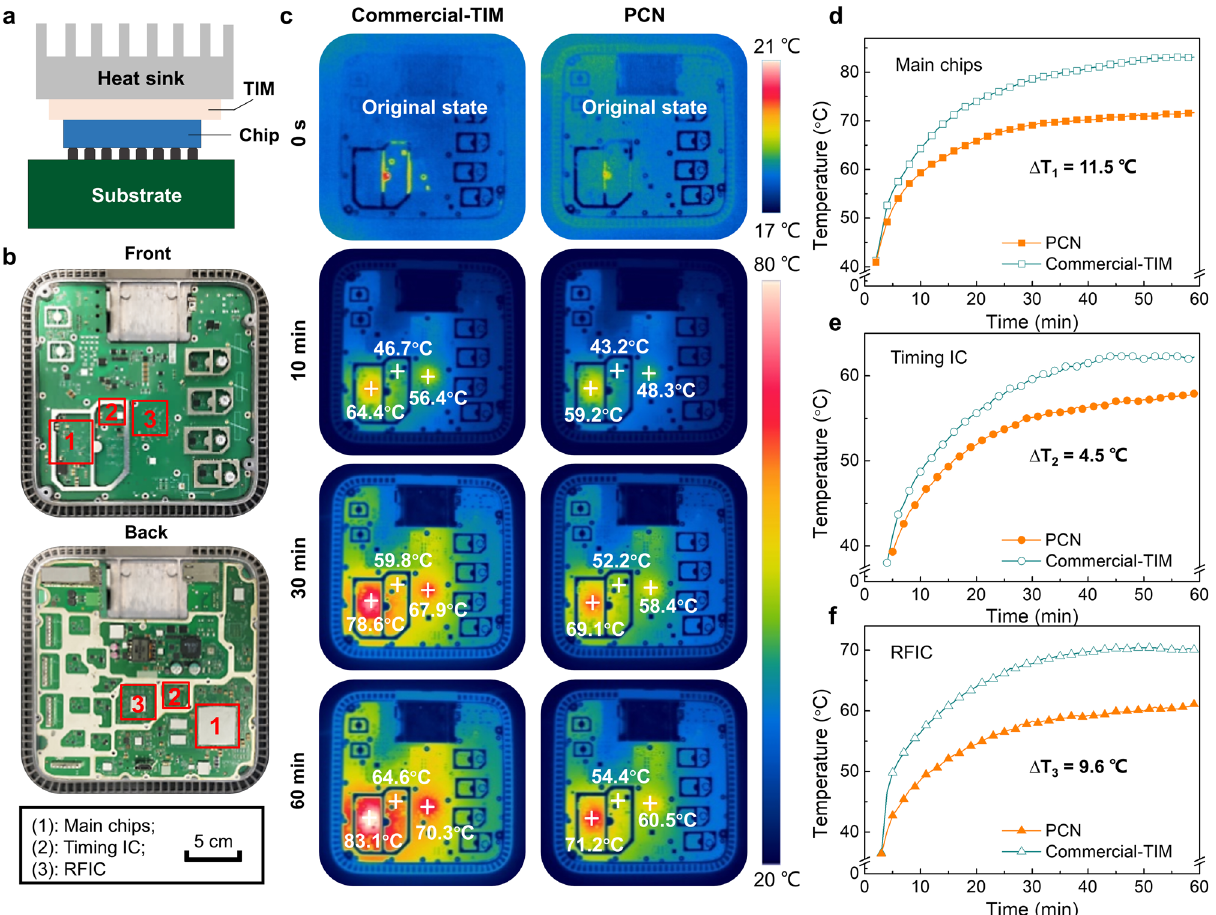
Fig. 5 Thermal management application of PEG@TPU/BNNS-es (PCN) film in a 5G base station. a Schematic diagram showing a chip inte- grated with a TIM in a 5G base station. b Optical photographs showing the front side (top) and the back side (bottom) of the 5G base station (without cover), and the regions identified by red squares as regions 1–3, corresponding to the main chips, timing IC and RFIC, respectively. c Infrared thermal images of the 5G base station integrated with commercial and PCN TIMs. Surface temperature versus time in d region 1, e region 2 and f region 3 in the 5G base station integrated with commercial TIM and